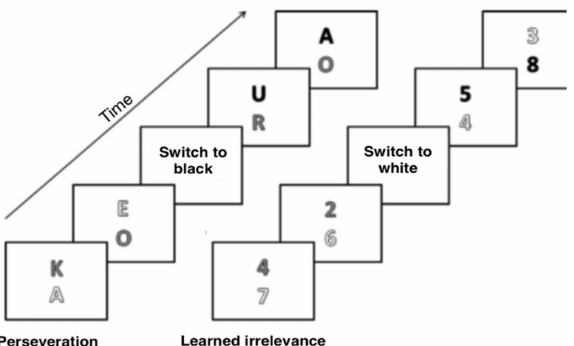
Figure 1. Sample order of trials for PE and LI conditions (the version of the task with letters and the version of the task with numbers are shown). The figure shows two trials before a color change and two trials after a color change. The different colors that appear in the quest are shown here as black, white, and gray. In both examples, gray is the target color before the change. In the LI condition, the target color changes to white, which was previously a distractor. In the PE condition, the previous target color (gray) becomes a distractor, and the new color (here black) becomes the target color. Own elaboration based on Dreisbach and Goschke